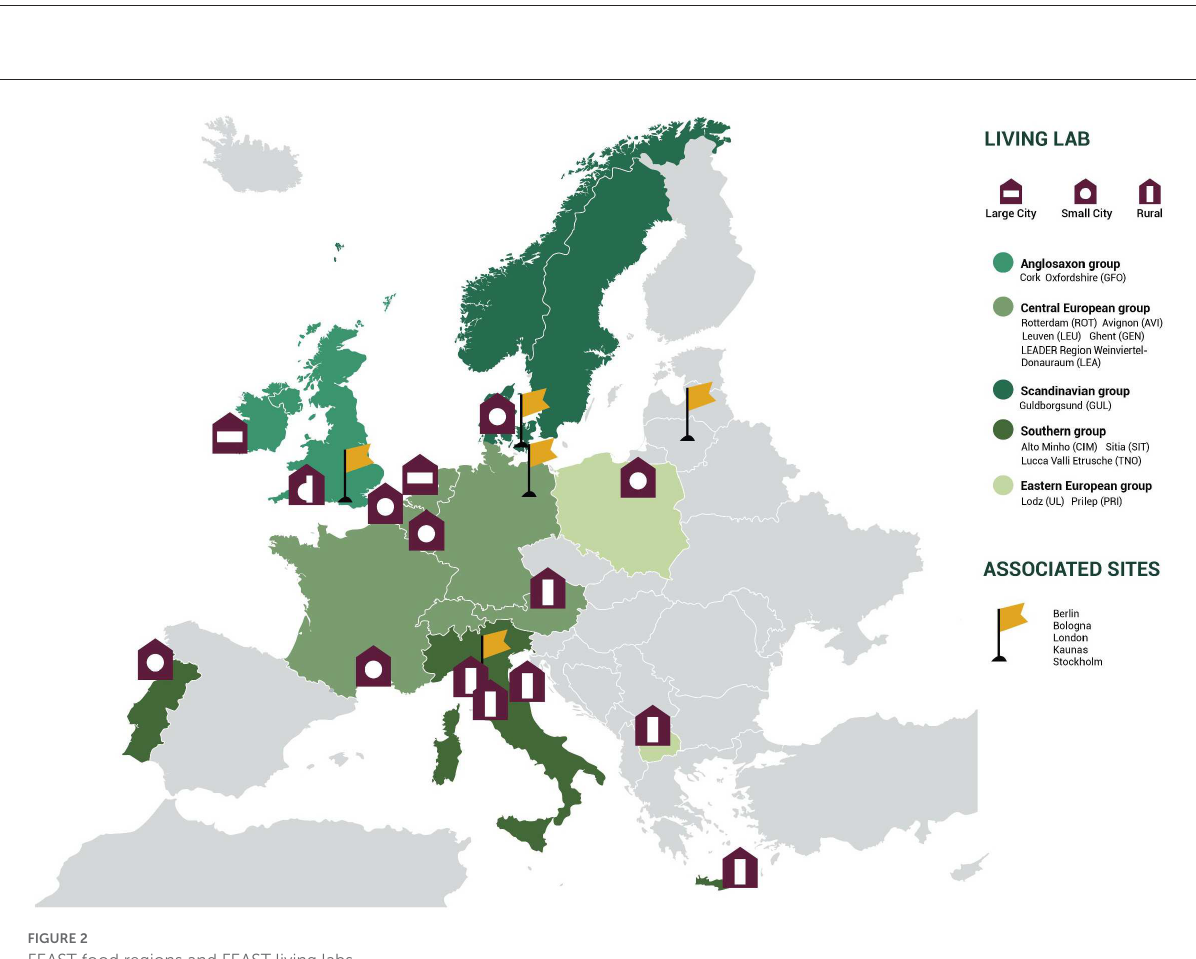
FIGURE2 FEAST food regions and FEAST living